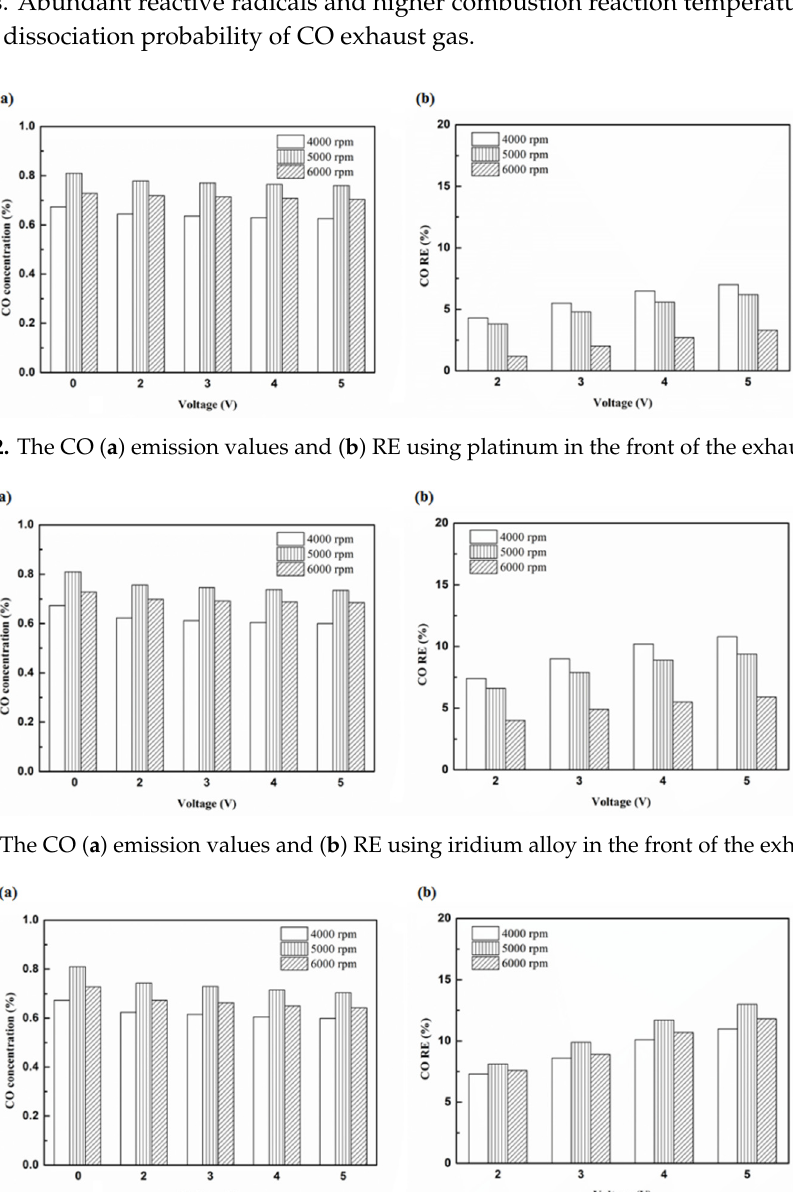
Molecules 2020 , 25 , x FOR PEER REVIEW 10 of 21 Table 6. The maximum and minimum values of HC removal efficiency at control voltage 5 V.